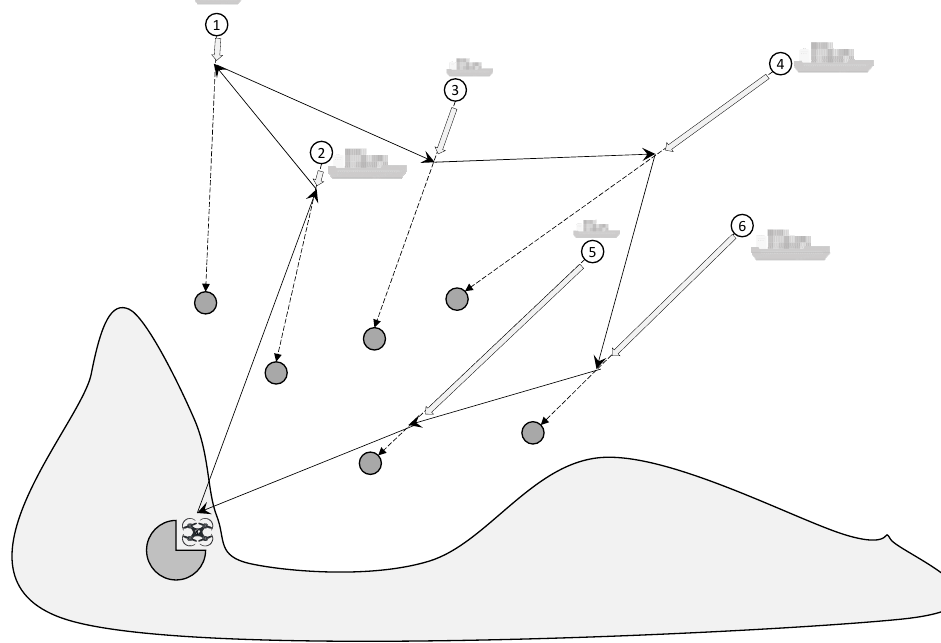
Figure 7. A conceptual diagram of drone routing for emission detection.